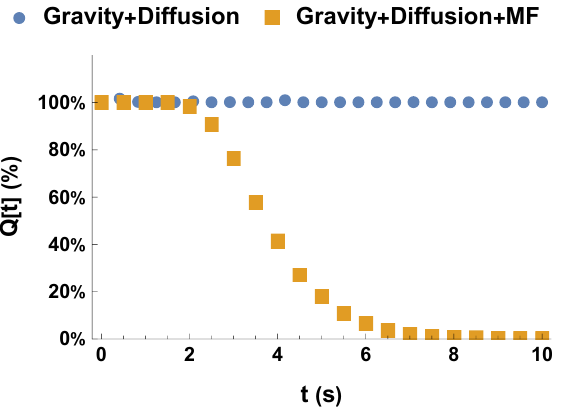
Figure 11. FeNP aggregates’ survival probability Q ( t ) in corn syrup. Blue circles represent particle motion under gravity and diffusion. Orange squares represent particles that are also exposed to a magnetic field.